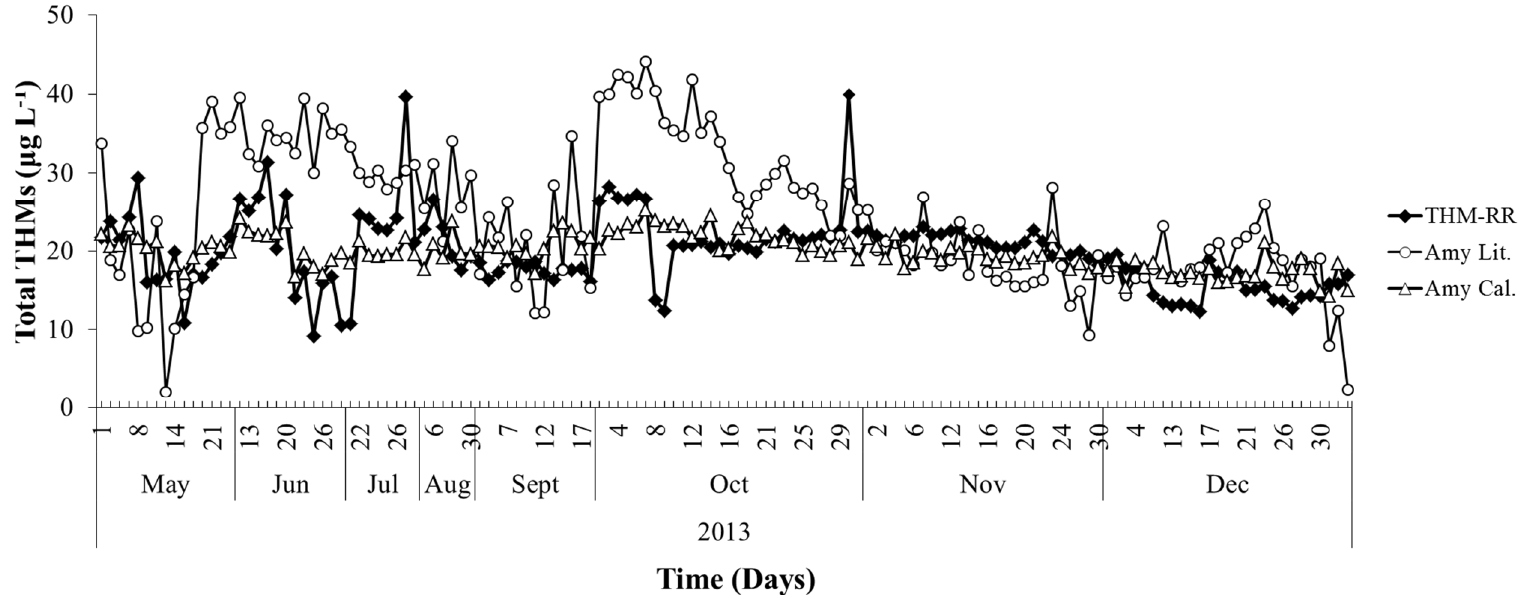
Figure 4. A plot of Total THMs vs. time from 1 May 2013 through 3 January 2014 is shown. The plot includes Total THMs concentrations measured using the THM-RR, Total THMs concentrations calculated using the Amy Literature model (Amy Lit.), and Total THMs concentrations calculated after the Amy model has been calibrated (Amy